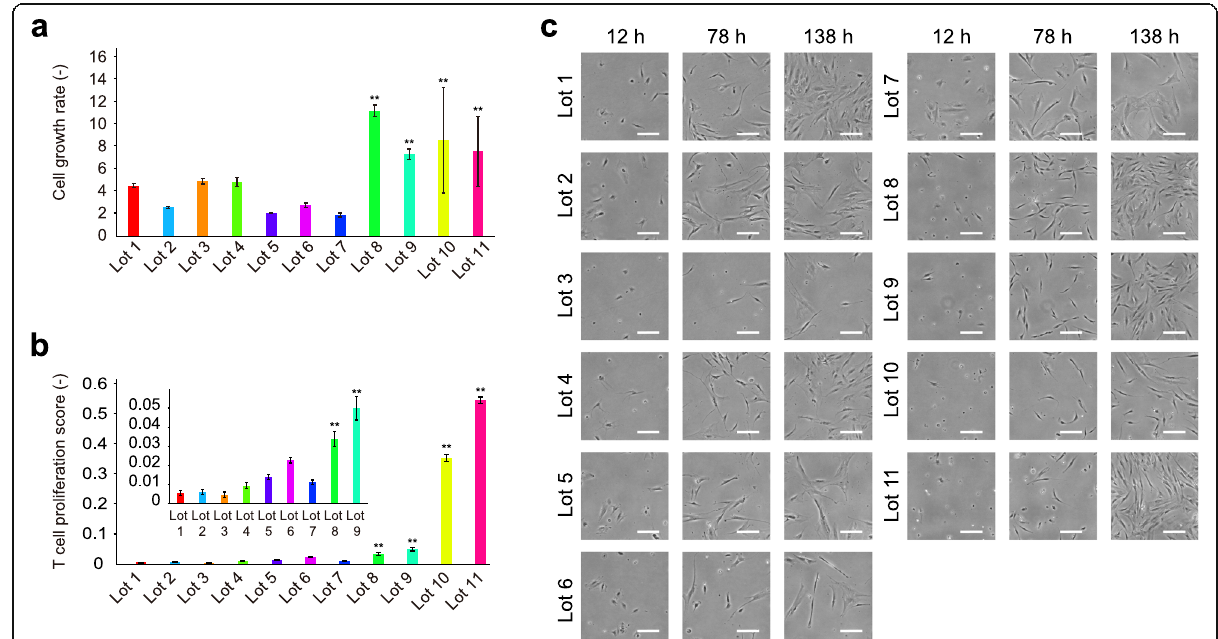
Fig. 2 Quality evaluation results of 11 lots of MSCs. a Growth rates ( N = 3). ** p < 0.05. b T-cell proliferation scores for evaluating T-cell proliferation inhibitory potency (inlet figure is the close of lot 1 to lot 9) ( N = 3). ** p < 0.05. c Representative morphological images. White scale bars indicate 200 μ